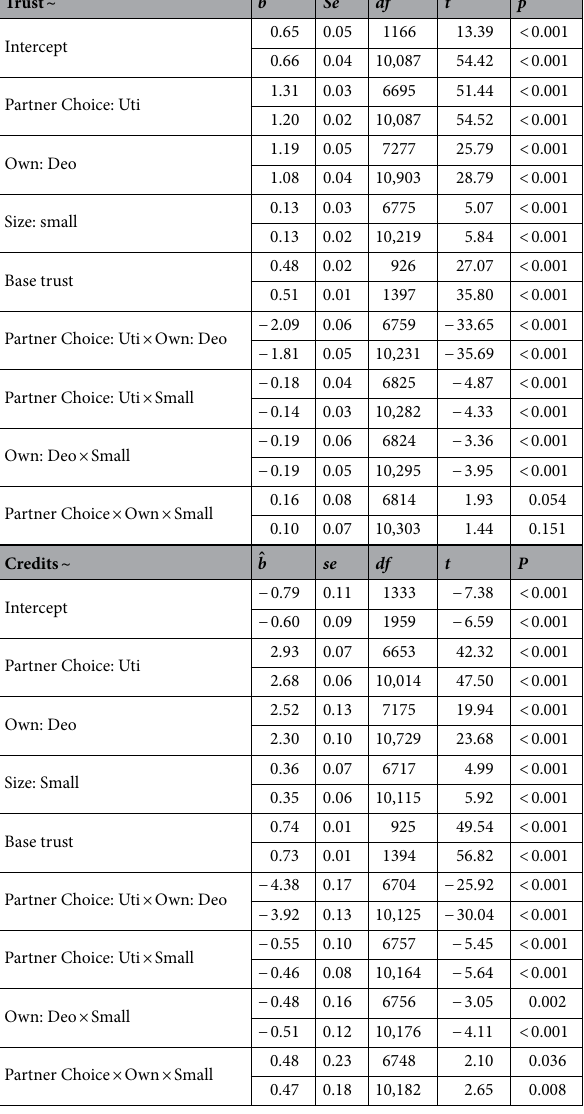
dummy variables: (1) Partner choice: 1 = Utilitarian, 0 = Deontological; (2) Own preference (i.e., participant’s own preference): 0 = Utilitarian, 1 = Deontological; (3) Size: 1 = Small, 0 =